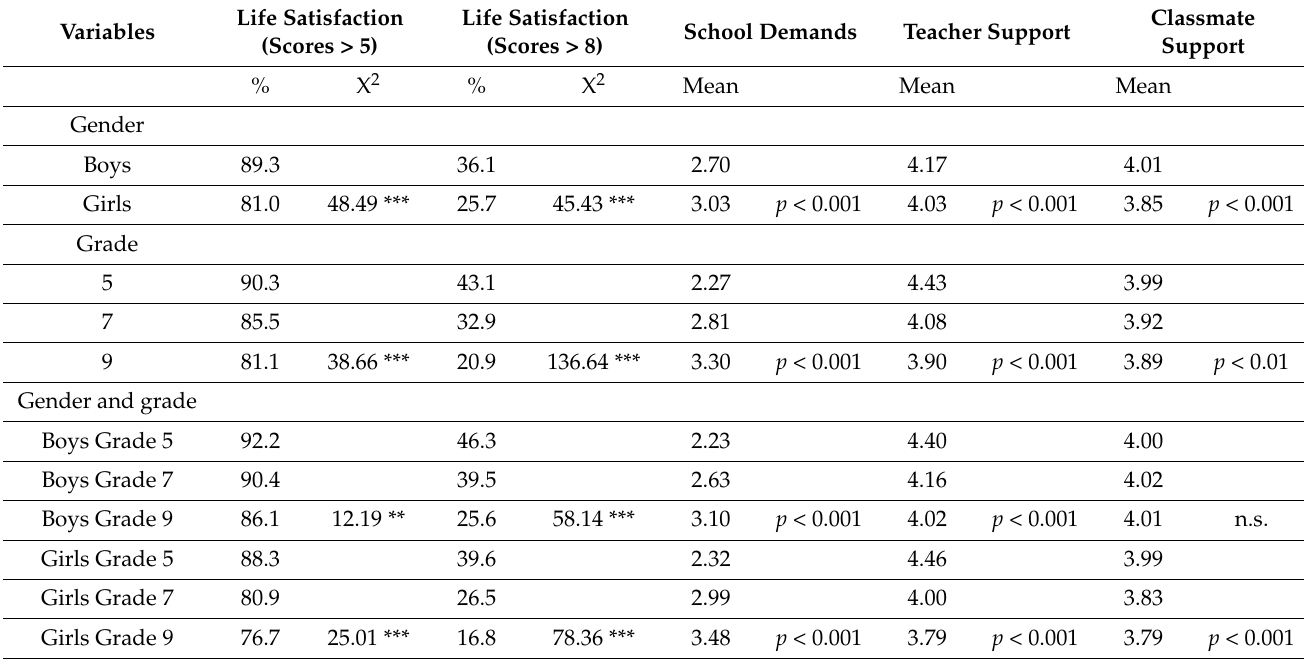
Table 2. Life satisfaction and psychosocial school conditions by gender and grade ( n =